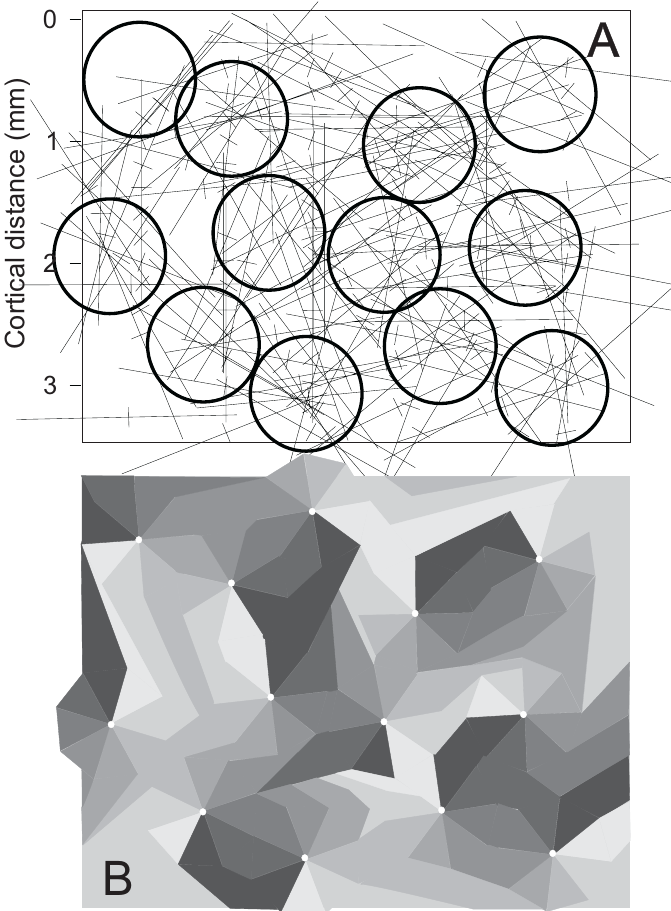
Fig. 5 – Pinwheels revealed by Braintemberg’s method on the plane of pene- tration illustrated in Figures 3 and 4. The method is based on the extension of successive lines (2 mm long) orthogonal to the axis-of-motion selectivity at each recording site. In A we considered centers of radial arrangements (circles) the location that had more than five intersections in a radius of 200 µ m. B is an artis- tic representation of the direction of motion map, where each half-tone density represents a range of 25